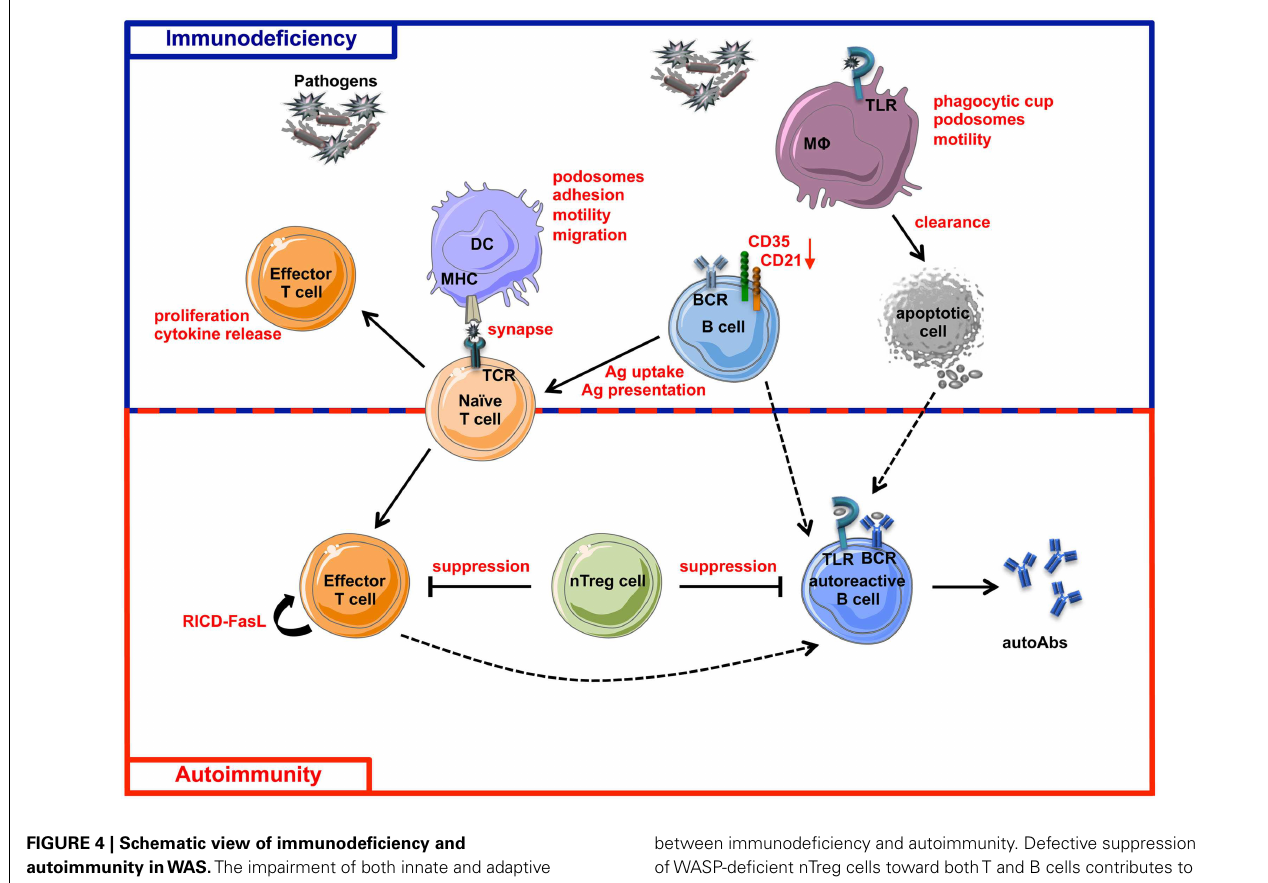
FIGURE 4 | Schematic view of immunodeficiency and autoimmunity inWAS. The impairment of both innate and adaptive immune systems is responsible of immunodeficiency (blue box) and autoimmunity (red box) inWAS. Immune cell defects described in WASP-deficient cells are shown in red.The incomplete pathogen clearance is sustained by cytoskeleton and functional defects of macrophages, DCs,T cells, B cells, and their defective interactions.The reduced expression of CD21 and CD35, two complement receptors involved in antigen uptake and presentation and also in negative selection of self-reactive B cells, places B cells at the interface